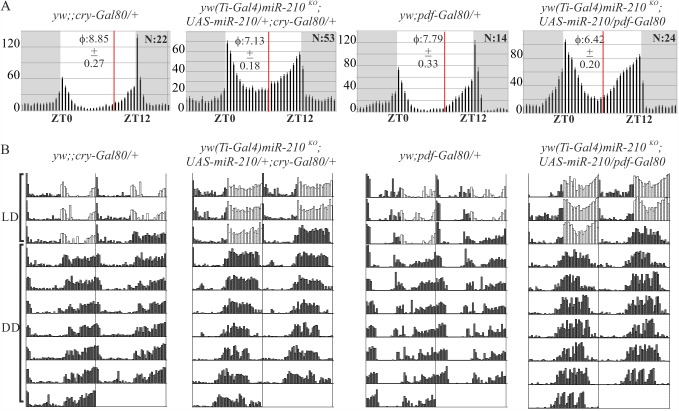
Locomotor activity of flies with miR-210 depletion in clock neurons.(A) LD locomotor activity profile (average activity of three full days displayed over the 24 hours) of yw(Ti-Gal4)miR-210KO;UAS-miR-210/+ flies combined with the cry-Gal80 or the pdf-Gal80 repressor transgenes, compared to controls (yw;;cry-Gal80/+ or the yw;pdf-Gal80 /+). ϕ: evening phase activity onset ± SEM (red lines); N: number of flies; y axis: activity (beam crosses/30 min) ± SEM; grey boxes: dark phase. (B) Double-plotted locomotor activity of a single representative fly per genotype, recorded for 3 complete days under LD and 7 complete days under DD. Flies with no miR-210 expression in CRY or PDF positive neurons severely phase-advanced their activity under DD.